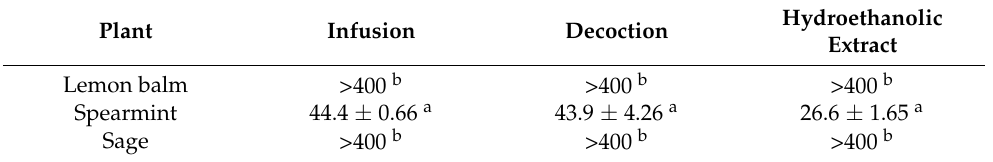
Hydroethanolic Extract